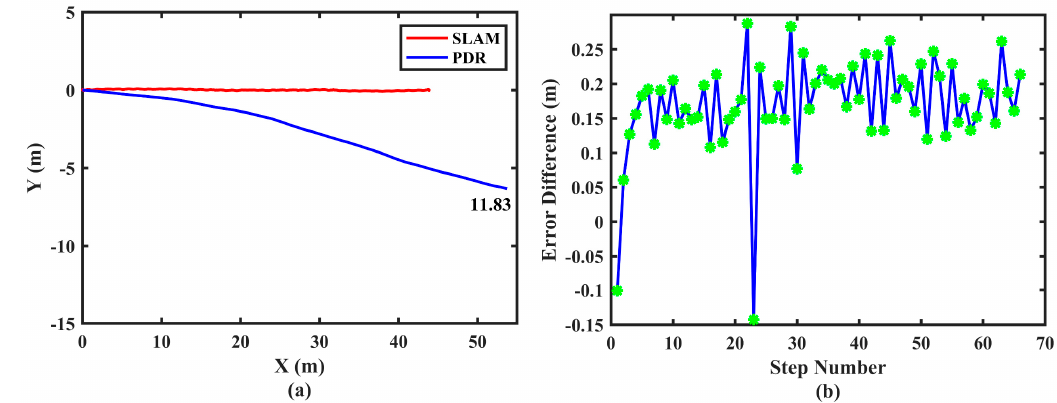
Figure 2. PDR results in the walking state. ( a ) The trajectory of PDR and SLAM (the truth value); ( b ) The error difference of PDR.